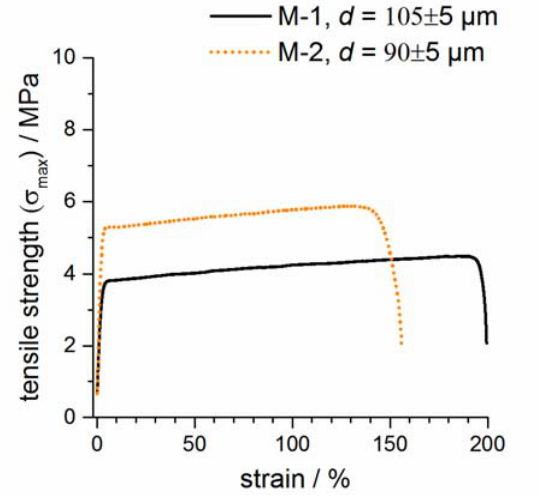
Figure 4. Representative tensile tests of both membranes are shown. The thickness ( d ) of both membranes are d (M ‐ 1) = 107 ± 10 μ m and d (M ‐ 2) = 91 ± 9 μ m (standard deviation). membranes are d (M-1) = 107 ± 10 µ m and d (M-2) = 91 ± 9 µ m (standard